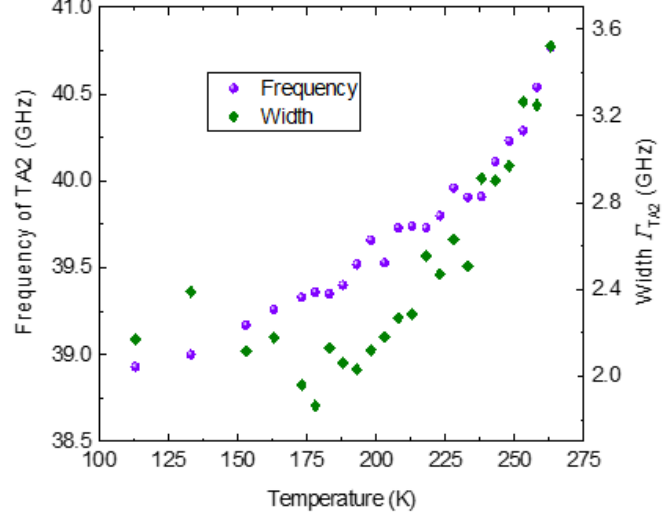
Figure 20. The frequency and the width of the TA2 phonon as a function of